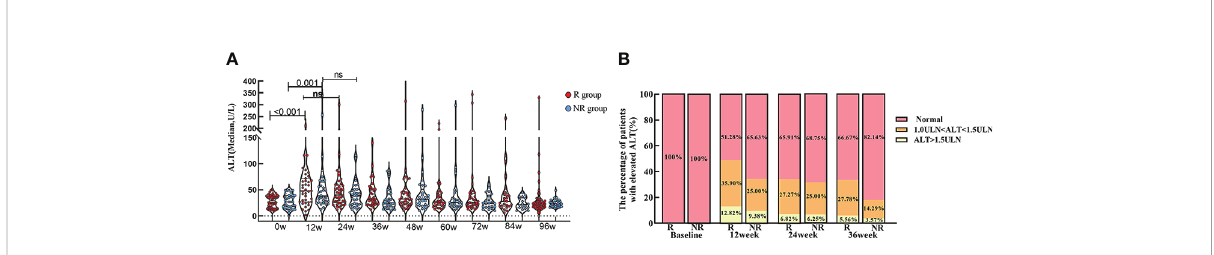
FIGURE 4 ALT level at baseline and during PEG-IFN treatment in R and NR group. (A) ALT level was signi fi cant higher both in R and NR group at week 12 than baseline (p < 0.001, p = 0.001). ALT level were not statistically different at each time point between R and NR group. (B) The proportion of patients with elevated level of ALT in R group was marginally larger than NR group, although there was no statistically signi fi cant